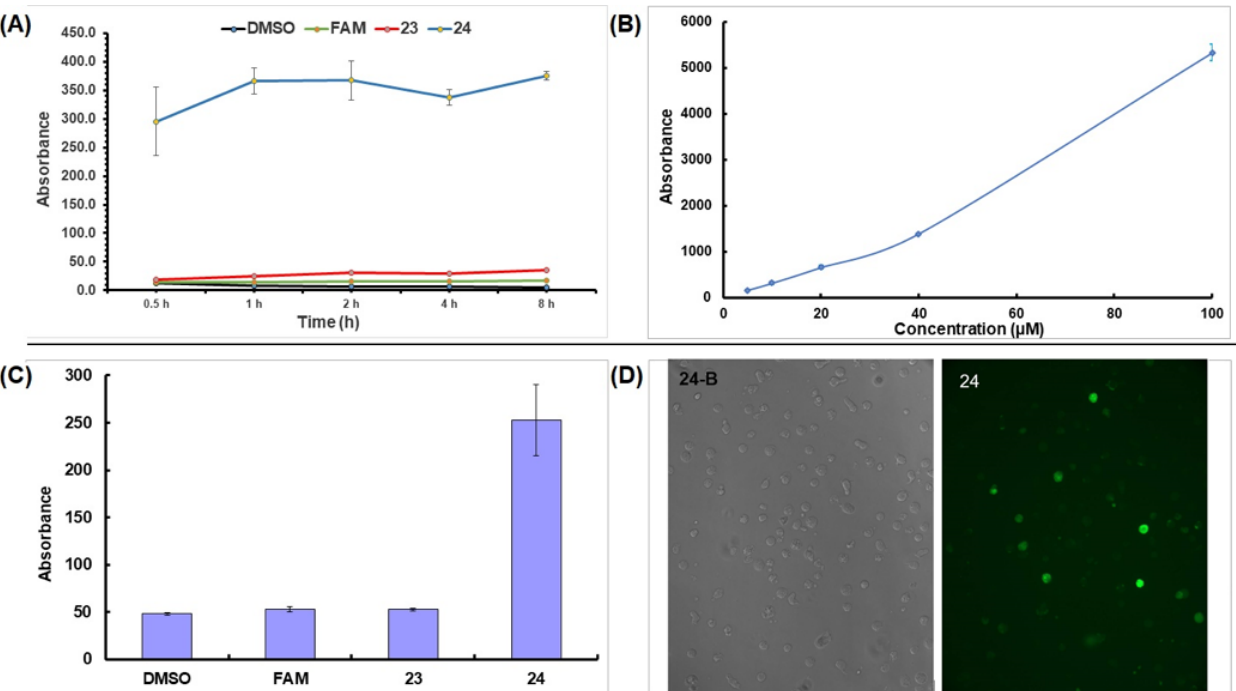
Figure 1. ( A ) Cellular uptake studies for 10 μ M of 5(6)-carboxyfluorescein derivatives of FLT (23 and 24) along with FAM and DMSO as the controls for the different time intervals. ( B )